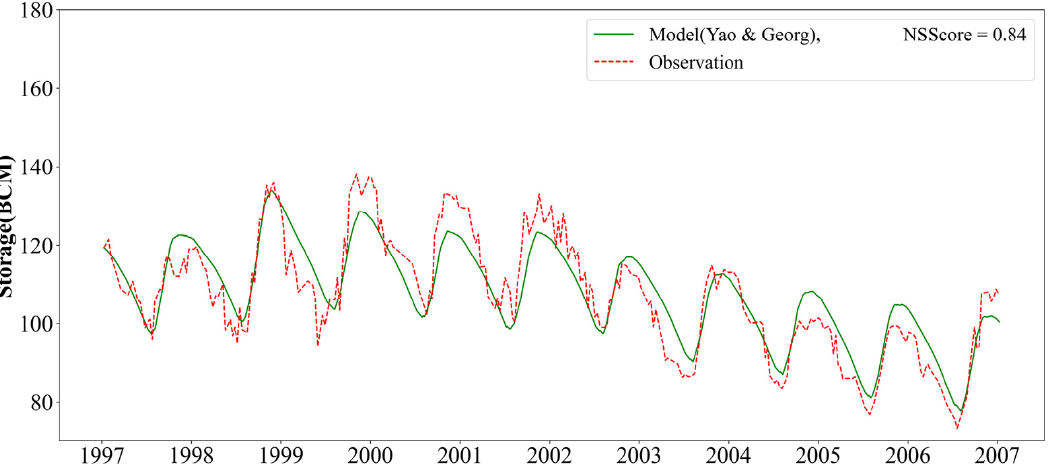
Figure 10. Simulated lake storage using the best evaporation estimation compared with historical data.